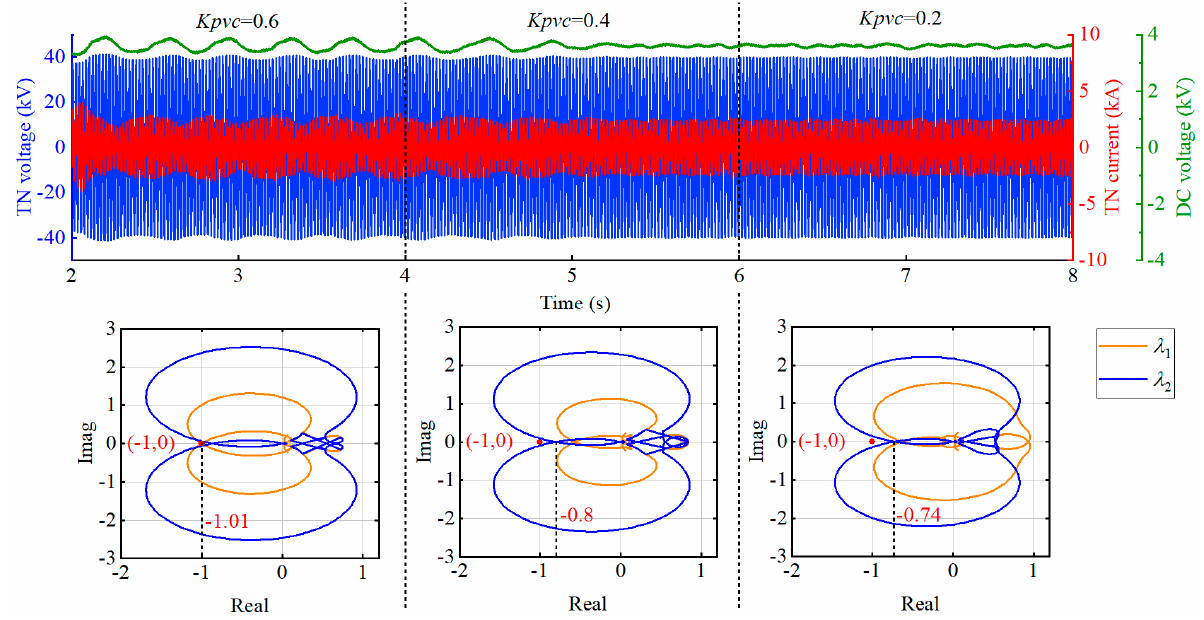
Figure 11. Influence of voltage loop PI proportional gain on system stability.